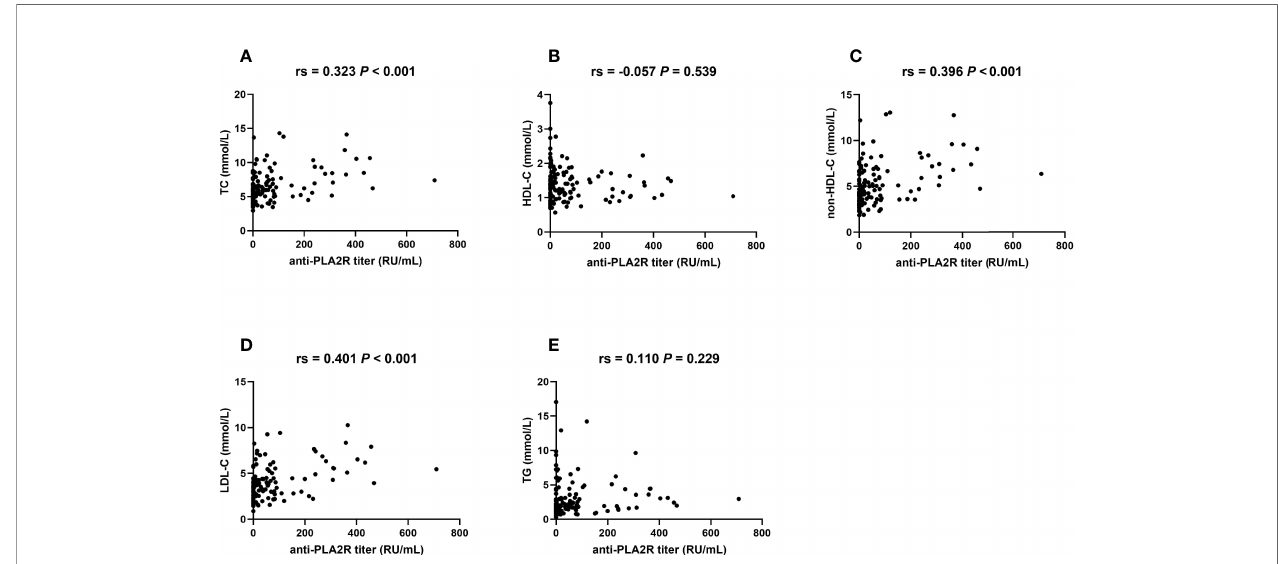
FIGURE 4 | TC, non-HDL-C, and LDL-C are correlated with serum anti-PLA2R titers. Bivariate scatterplots relating anti-PLA2R titers to TC (A) , HDL-C (B) , non- HDL-C (C) , LDL-C (D) , and TG (E) , including P -values for Spearman ’ s analysis (N = 124). Rs: Spearman ’ s rank correlation coef fi cient.